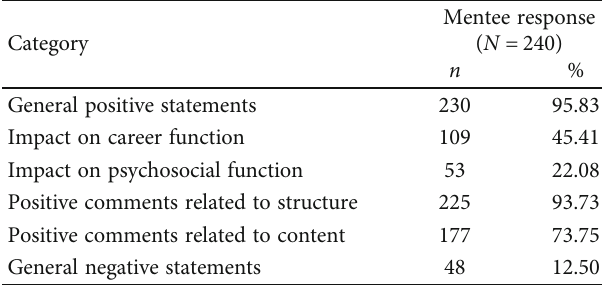
Table 1: Percentage endorsement based on codes. Table 2: Percentage endorsement based on